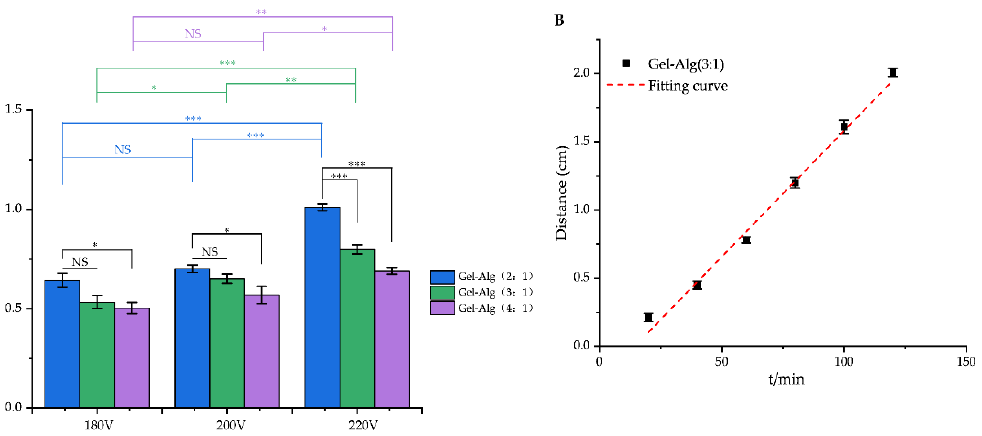
Figure 5. The migration behavior of berberine under electric field. ( A ) The migration distance of berberine hydrochloride in the Gel–Alg hydrogel with different proportions (2:1, 3:1 and 4:1) under different voltages. The data are means ± SD ( n = 3), and statistical comparisons were made using one-way ANOVA followed by Duncan’s test (NS p > 0.05, * p < 0.05, ** p < 0.01, *** p < 0.001. Black represents the statistical difference between each condition verse Gel–Alg (2:1) at the same voltage; blue represents the statistical difference of Gel–Alg (2:1) between different voltages; green represents the statistical difference of Gel–Alg (3:1) between different voltages; purple represents the statistical difference of Gel–Alg (4:1) between different voltages); ( B ) Migration distance and fitting curve of berberine hydrochloride in the Gel–Alg (3:1) hydrogel at different time